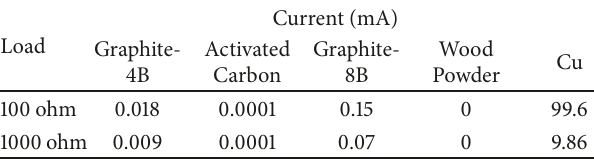
Table 2: Current measurement of